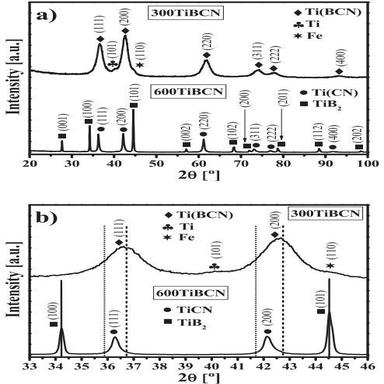
a) X-ray diffraction (XRD) patterns for the 600TiBCN and 300TiBCN samples. (■) TiB2; (•) Ti(CN); (♦) Ti(BCN); (♣) Ti hcp; (★) Fe. b) Magnification of the XRD patterns in the 33–43° 2θ range showing the displacements of the (111) and (200) Ti(CN) peaks. Continuous, dotted and dashed lines designate the positions for the corresponding reflections of TiB2, TiC and TiN, respectively.